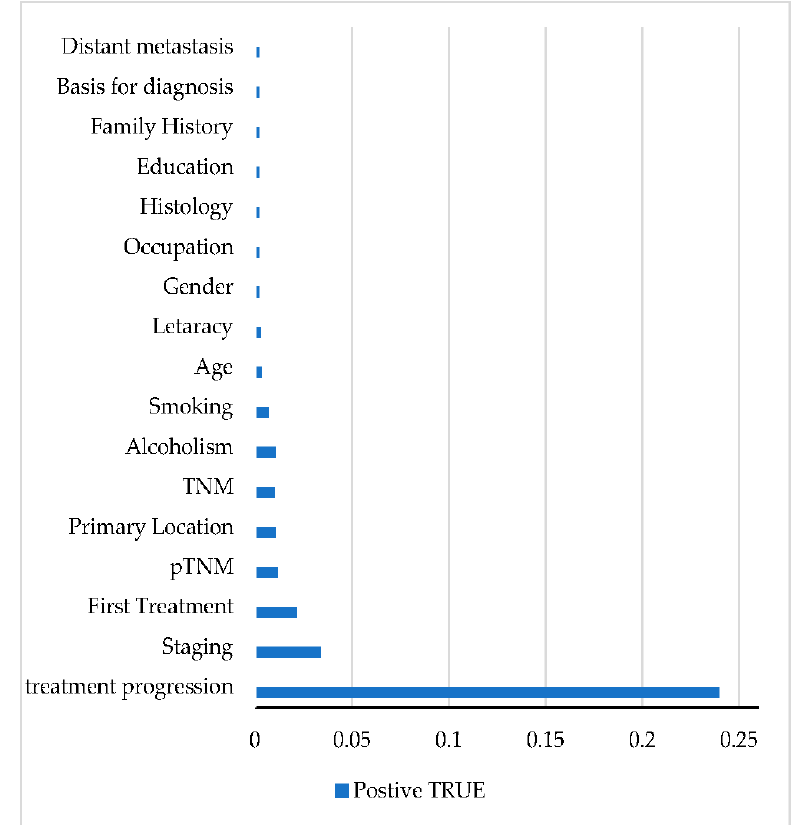
Figure 4. Classification of variables for breast cancer; classification of variables according to the importance for prediction (vimp). Blue bars indicate positive influence; red bars indicate negative influence.